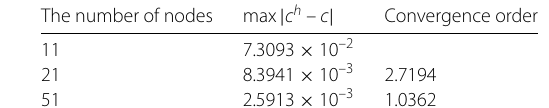
Table 2 The convergence order of the proposed algorithm when number of nodes is 11, 21, 51,